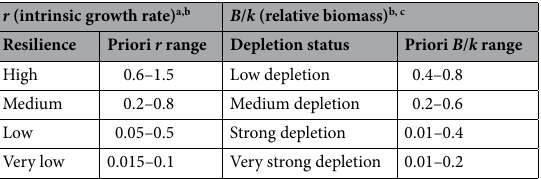
Table 1. Priori ranges of r and B / k for CMSY. a Referred from Fishbase (www. fishb ase. org); b referred from Froese et al . 14 ; c referred from Froese et al . 19 .